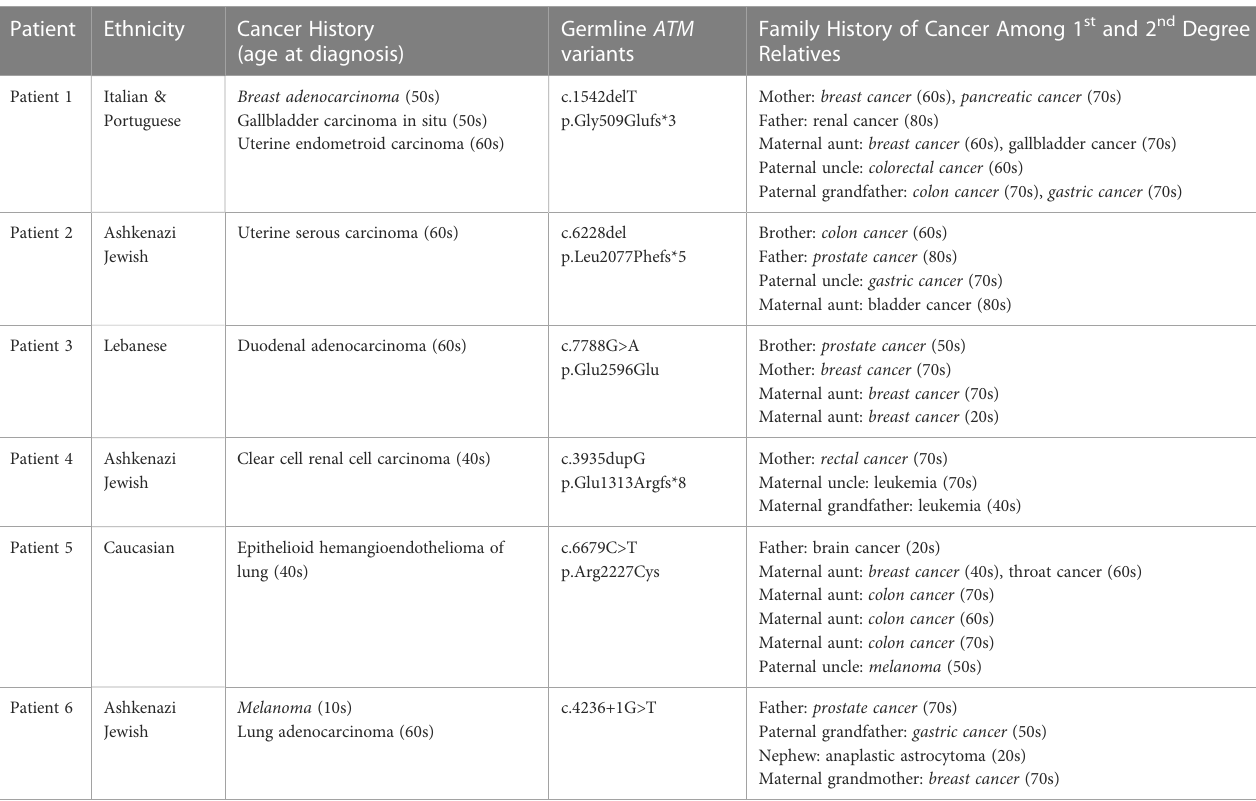
TABLE 1 Clinical summary of the six patients identi fi ed to harbor a pathogenic germline variant in ATM and a personal history of cancer not associated with ATM hereditary cancer syndrome. Patient Ethnicity